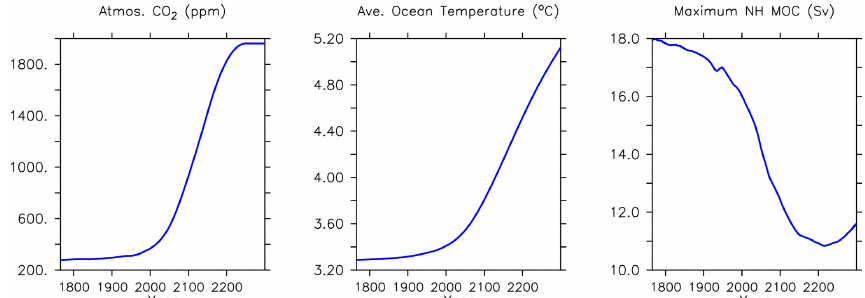
Figure 24. Major physical changes in the model from 1776 to 2300.